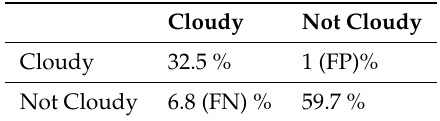
Table 4. Confusion matrix of the CloudScout model run on the entire dataset.